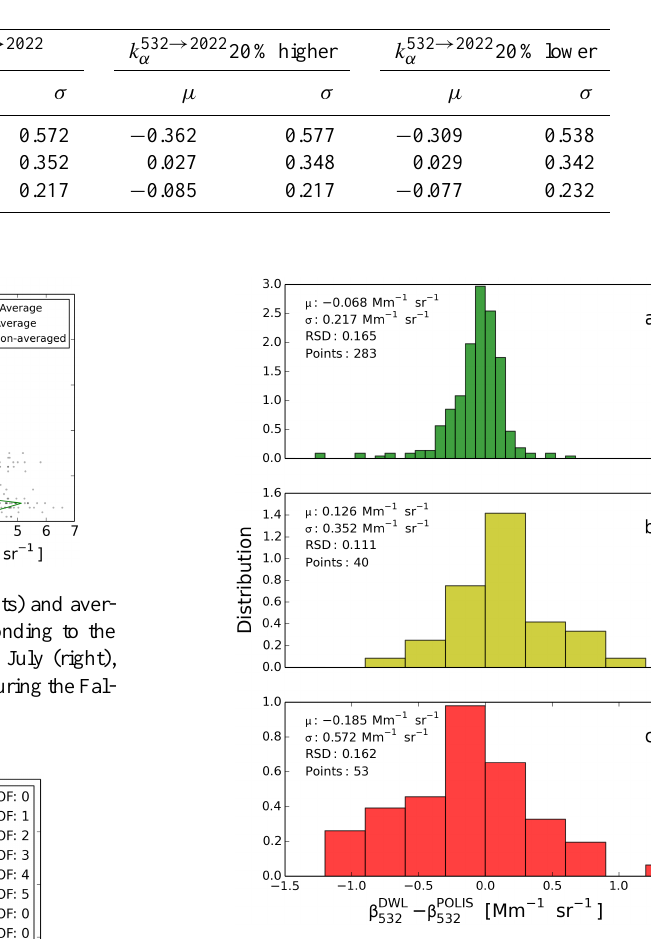
Table 4. Mean error µ [Mmsr − 1 ] and standard deviation σ [Mmsr − 1 ] as function of the aerosol layer and extinction coefficient conversion factor.